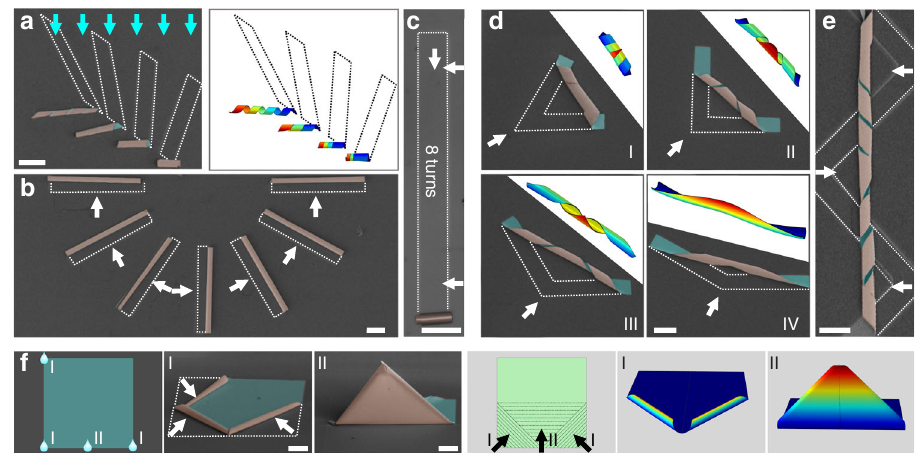
Fig. 4 A set of microstructures assembled by deterministic delamination strategy. a Experimental result (left, SEM image) and FEM model (right) of different helical microstructures constructed from parallelogram-shaped nanomembranes with different interior angles. Blue arrows depict direction of liquid fl ow. Scale bar, 100 μ m. b SEM image of microtubes arranged in a circle. White arrows depict rolling direction of nanomembranes. Scale bar, 100 μ m. c Optical image of rolled-up microtubes with 8 turns. Scale bar, 100 μ m. d Experimental results (SEM image) and FEM model of helical frameworks with opposite chirality, pitch of which was tuned by the angle between two ribbons. Scale bar, 100 μ m. e SEM image of ultralong helical framework with different chirality constructed from zig-zag-shaped nanomembrane. Scale bar, 100 μ m. f Experimental results (left, SEM images) and FEM model (right) of folding microstructure constructed by multi-step deterministic delamination (I and II). Scale bar, 100 μ m